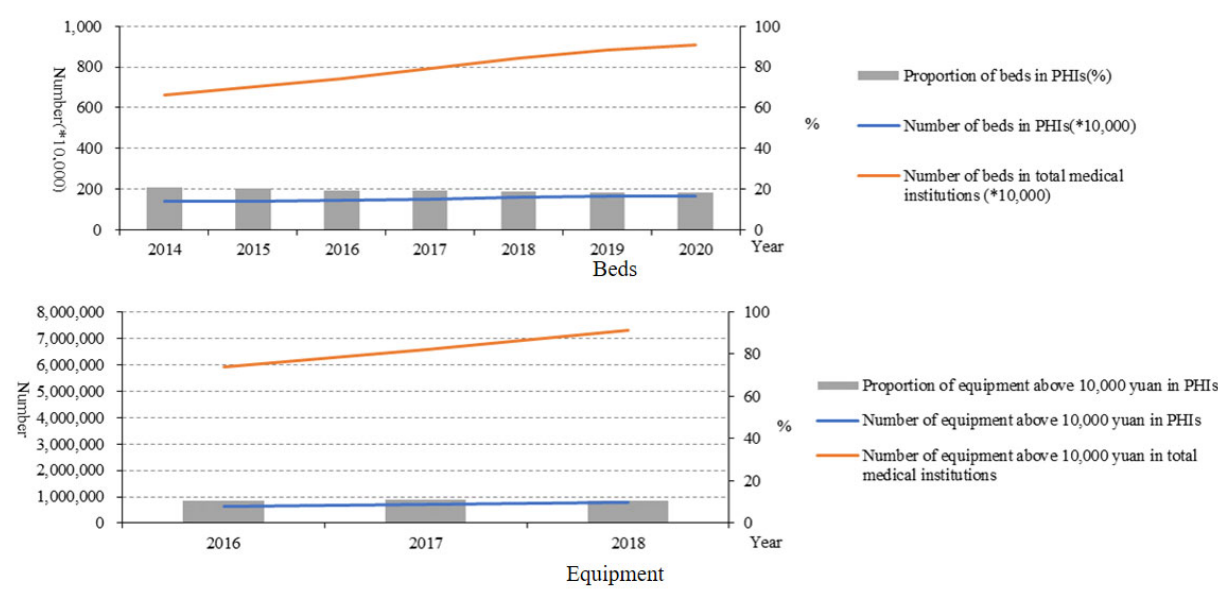
Figure 4. Beds and equipment above 10,000 yuan in medical institutions and PHIs.